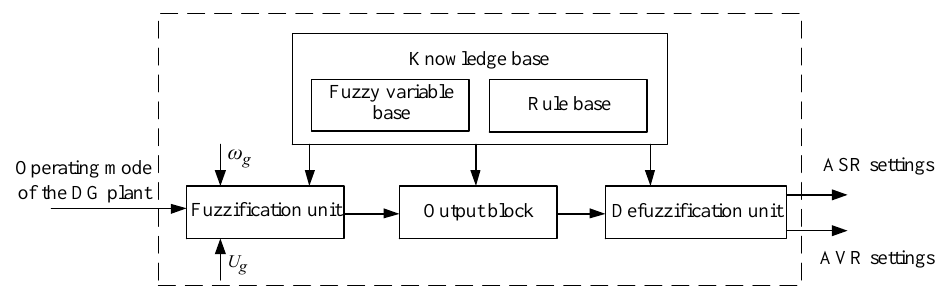
Figure 2. Block schematic diagram of a fuzzy controller that changes AVR and ASR settings. As a footnote, fuzzy models are widely used in distributed generation, including Takagi–Sugeno fuzzy modes, see [59] and references therein.